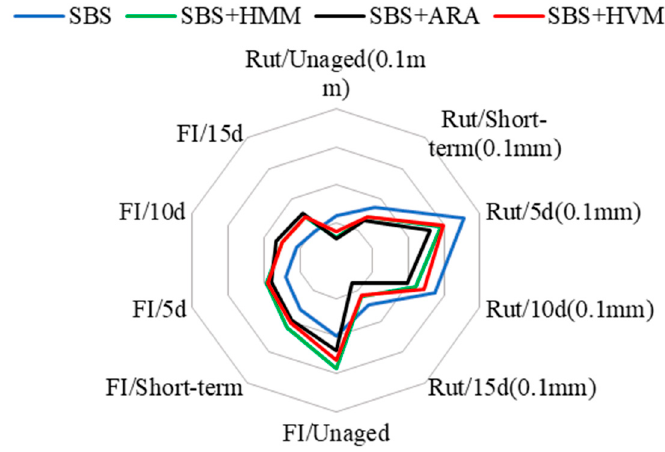
Figure 10. Performances of different polymer-modified asphalt mixtures.